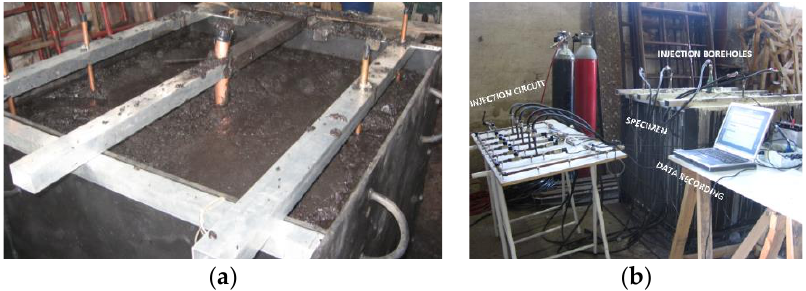
Figure 2. ( a ) Preparation of the coal sample for CO 2 generation tests. ( b ) Set-up of the equipment for the CO 2 generation tests at a medium scale.